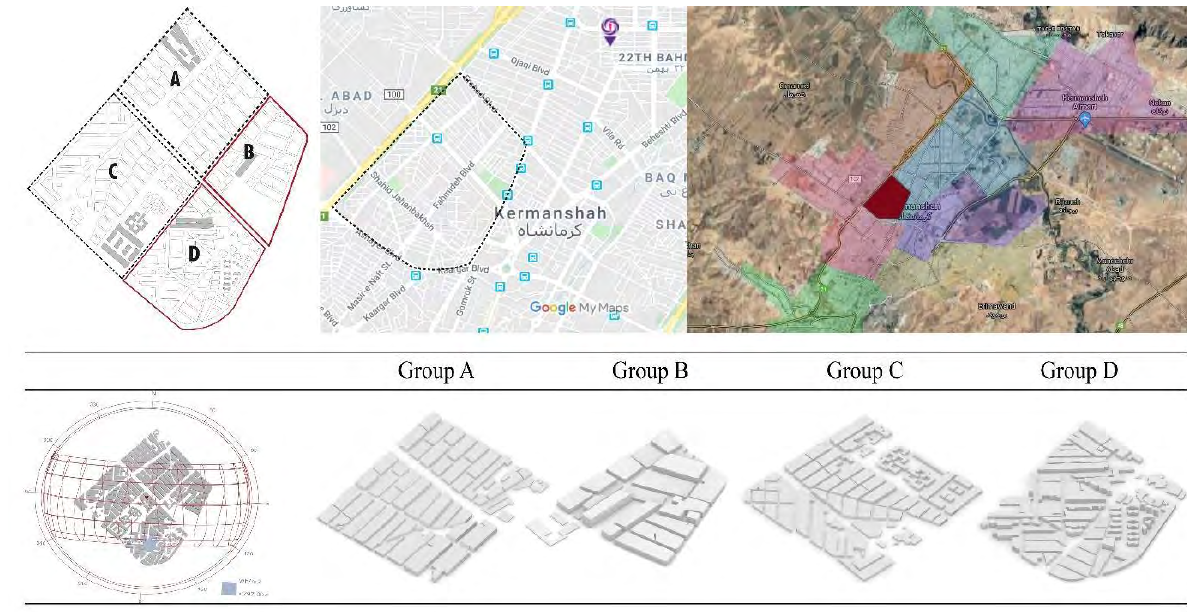
Figure 2- Location of region 2 in Kermanshah and the relative location of the research